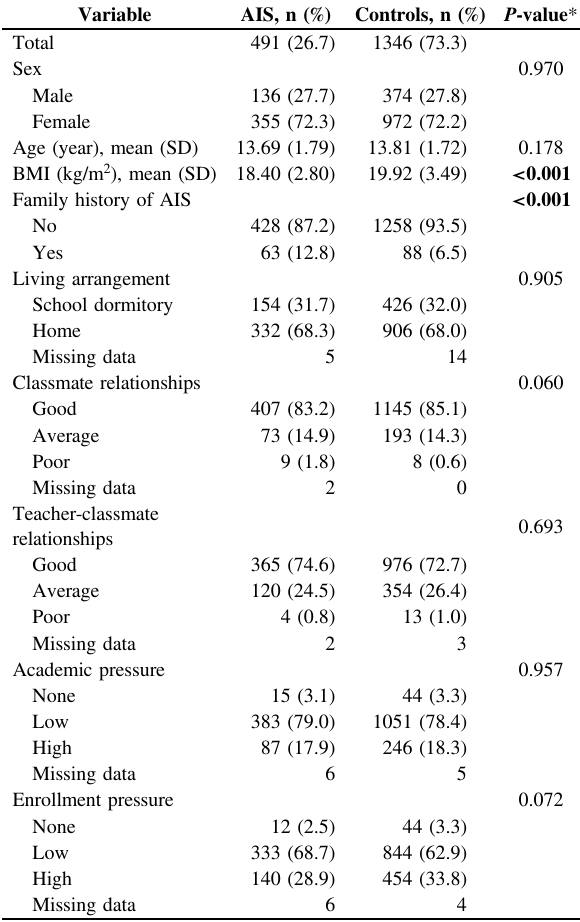
Table 1 Demographic characteristics of all